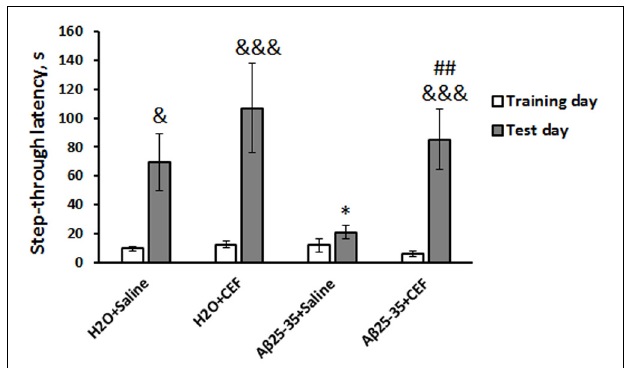
FIGURE 1 | Effects of the CEF and A β 25–35 administration (AD model) on memory retrieval in mice in the passive avoidance test. The data are expressed as mean ± SEM of the values obtained in an independent group of animals ( n = 5–6 per group). Statistically significant differences: & p < 0.05, &&& p < 0.001 compared with values of the same group on the training day; ∗ p < 0.05 vs. the “H 2 O + saline” group on the test day; ## p < 0.01 vs. the “A β + saline” group on the test